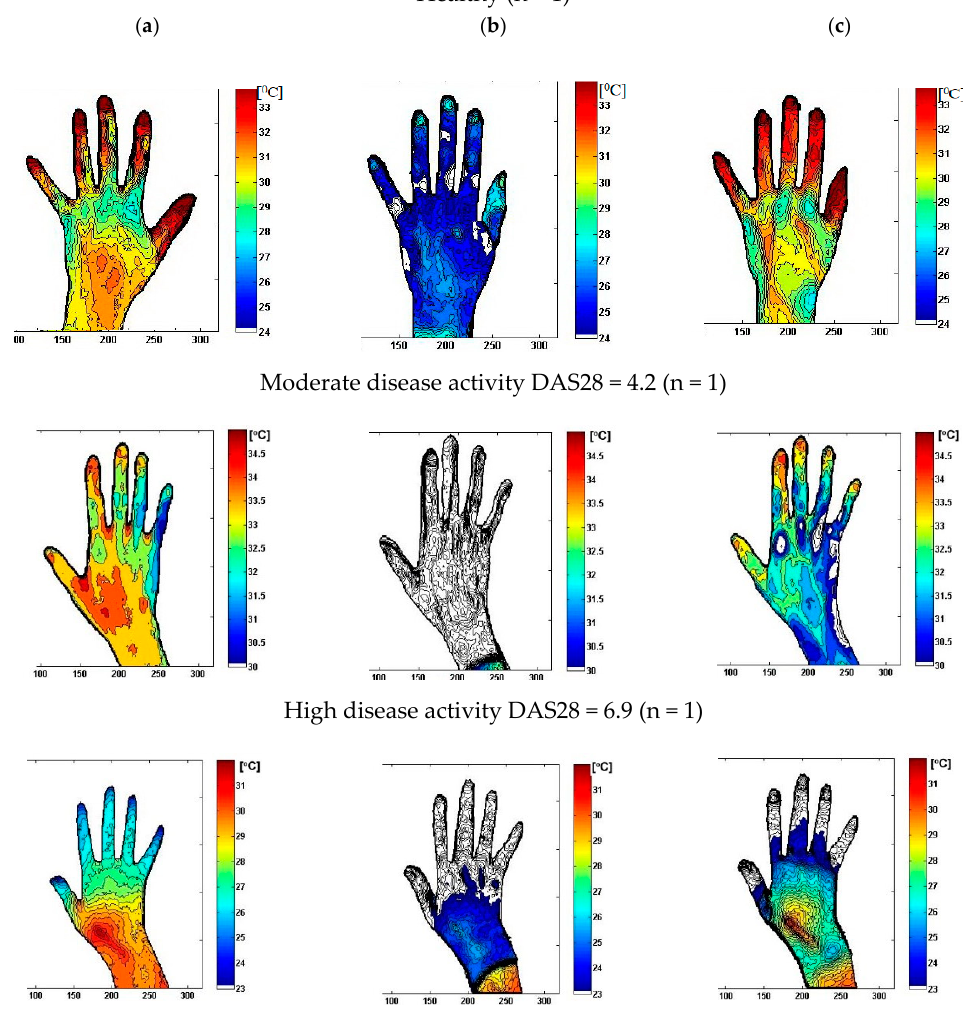
Figure 6. Distribution maps collected for a randomly selected subject from the experimental group: High disease activity (HD), Moderate disease activity (MD), Healthy (H): ( a ) In static; ( b ) post-cooling; ( c ) post-rewarming.